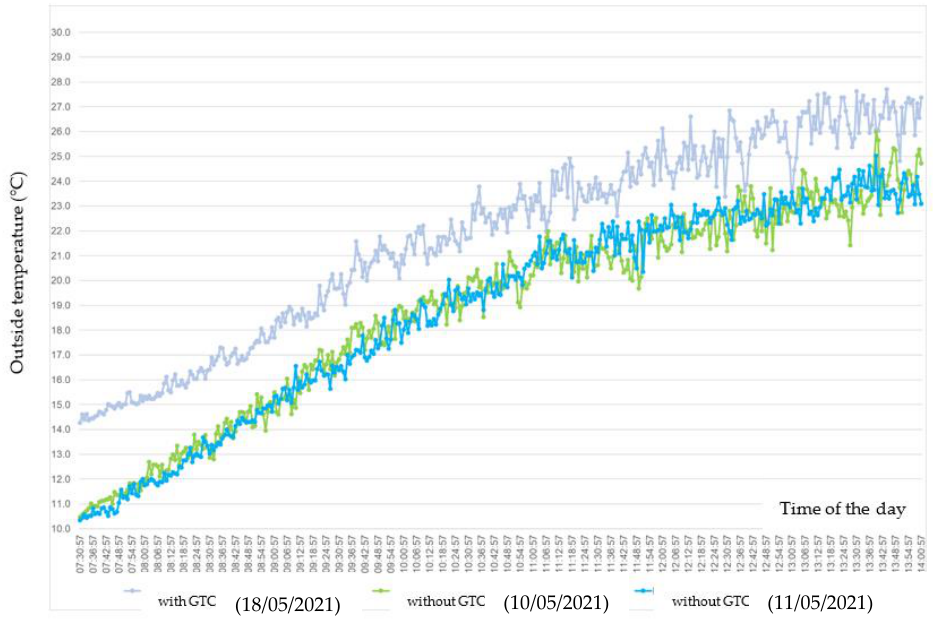
Figure 14. Days chosen for analysis: outside temperature.